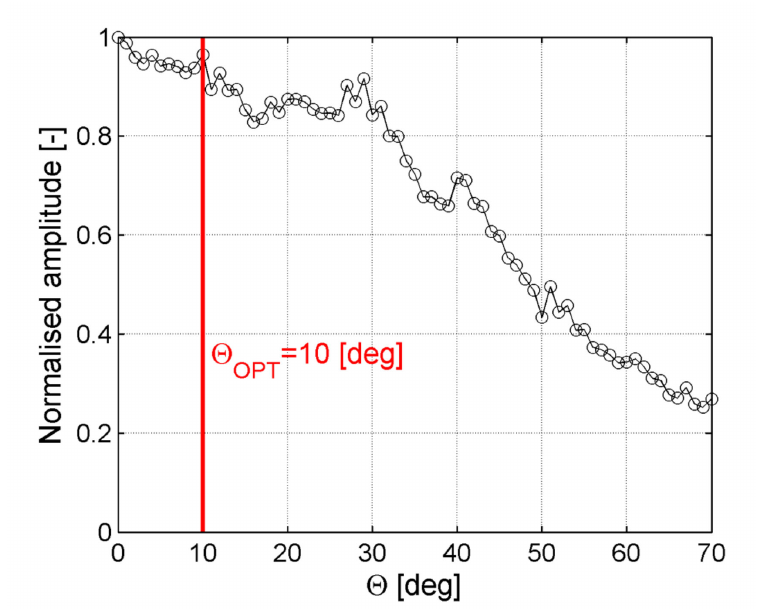
Figure 14. Normalized amplitude of the SH 0 wave mode in a function of ACT slope angle θ for waves generation across reinforcing